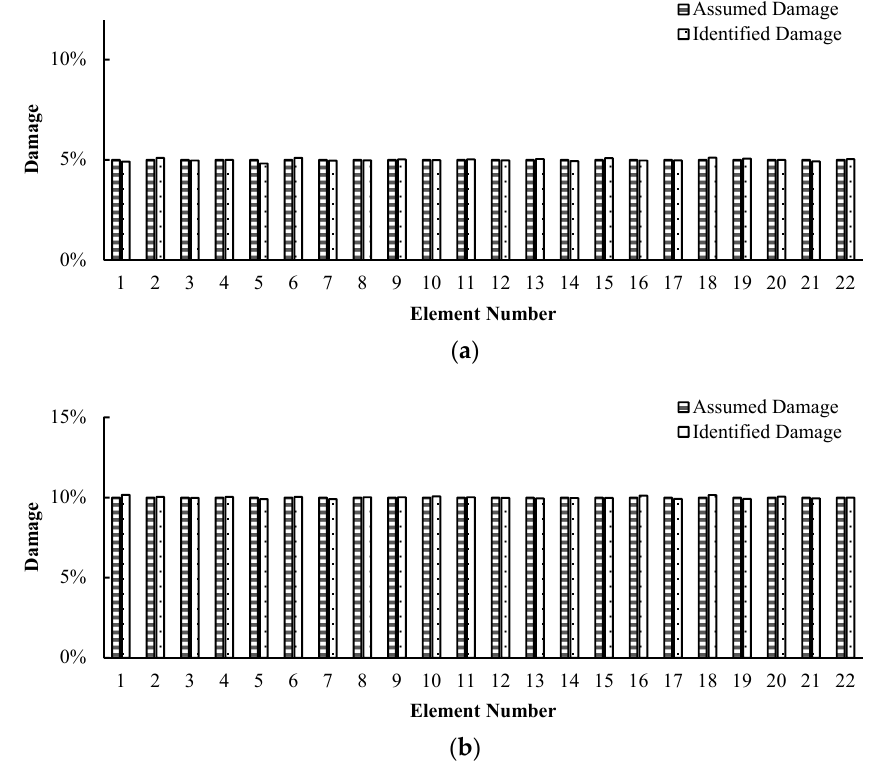
Figure 17. Results of damage identification. ( a ) 5% uniform damage (20 °C). ( b ) 10% uniform damage (20 °C). Table 4. Determination of damage using statistical criterion.